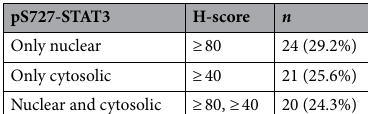
Table 3. Incidence of different pS727-STAT3 expression patterns in ccRCC